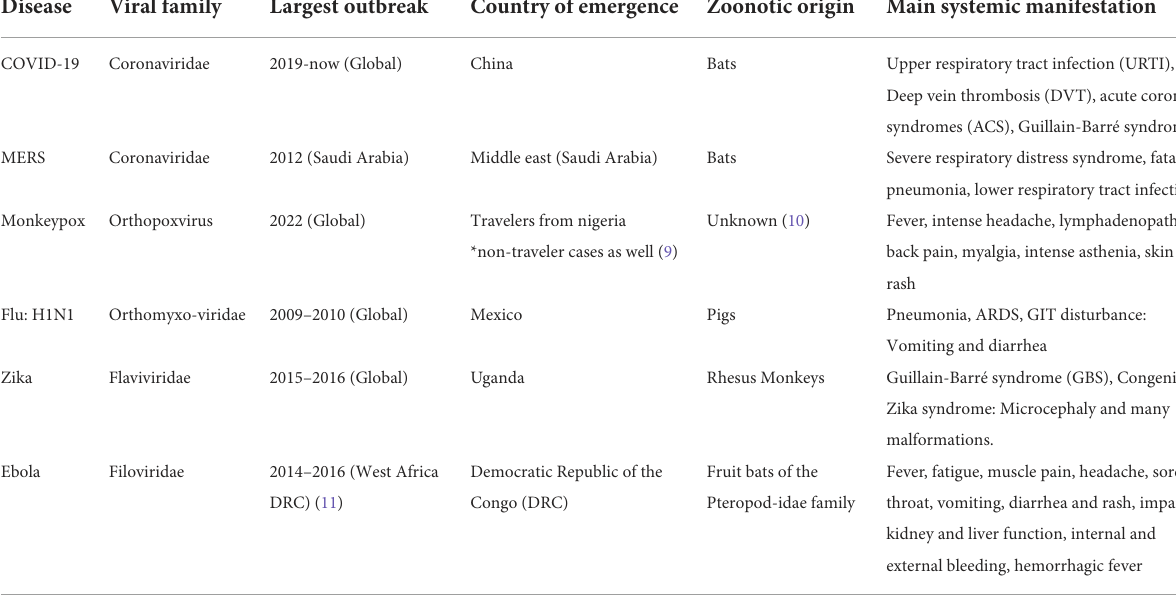
TABLE 1 WHO’s emergency viral pandemics.